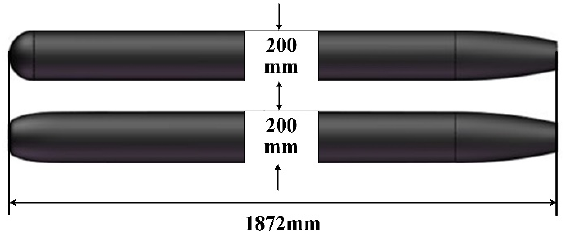
Figure 1. Flat ‐ and round ‐ nosed vehicles. Figure 1. Flat- and round-nosed vehicles.